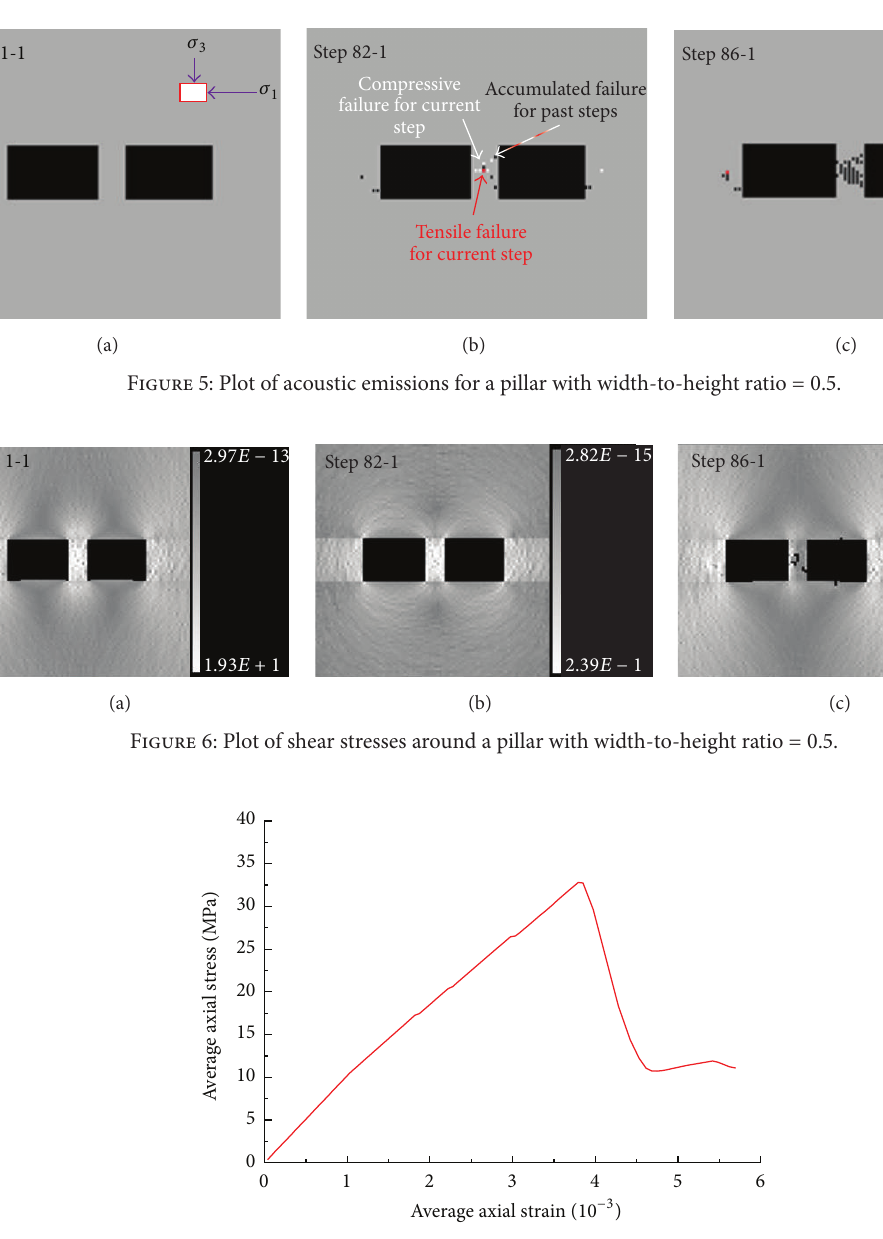
Figure 7: Average axial stress-strain curve for a pillar with width-to-height ratio = 0.5.